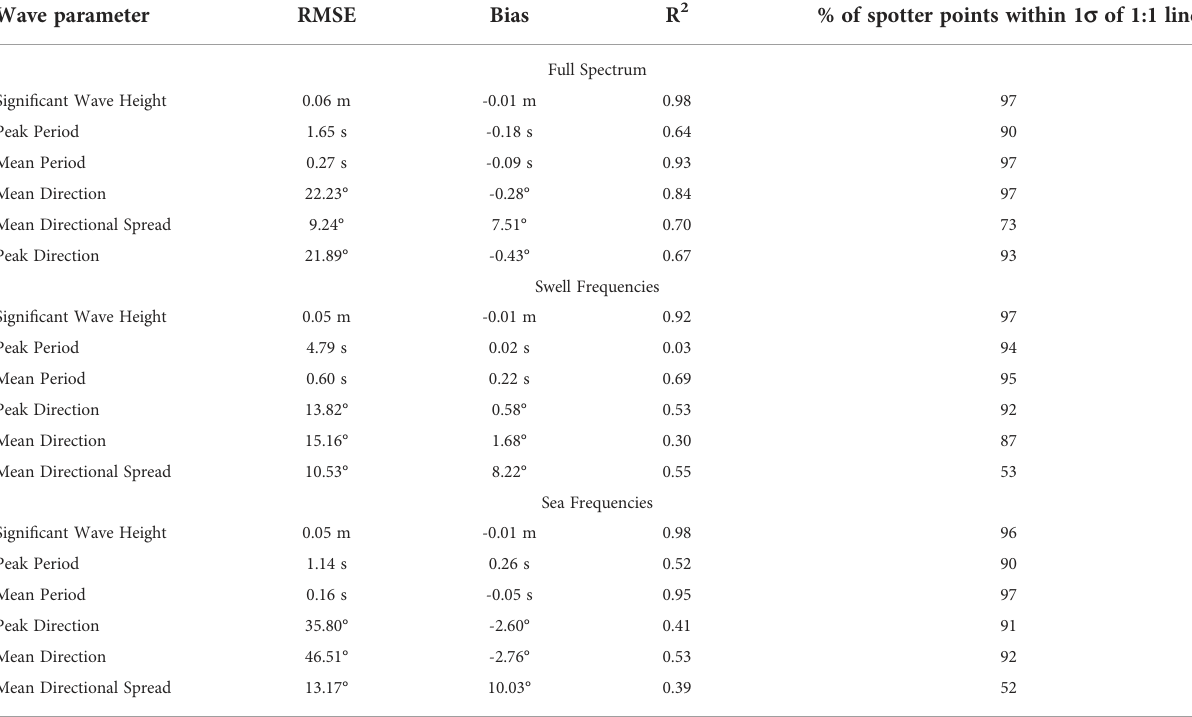
TABLE 1 Statistics comparing bulk wave statistics reported by the Datawell and Spotter wave buoys for the full wave spectrum and swell and sea frequencies. Wave parameter RMSE Bias R 2 % of spotter points within 1 s of 1:1 line